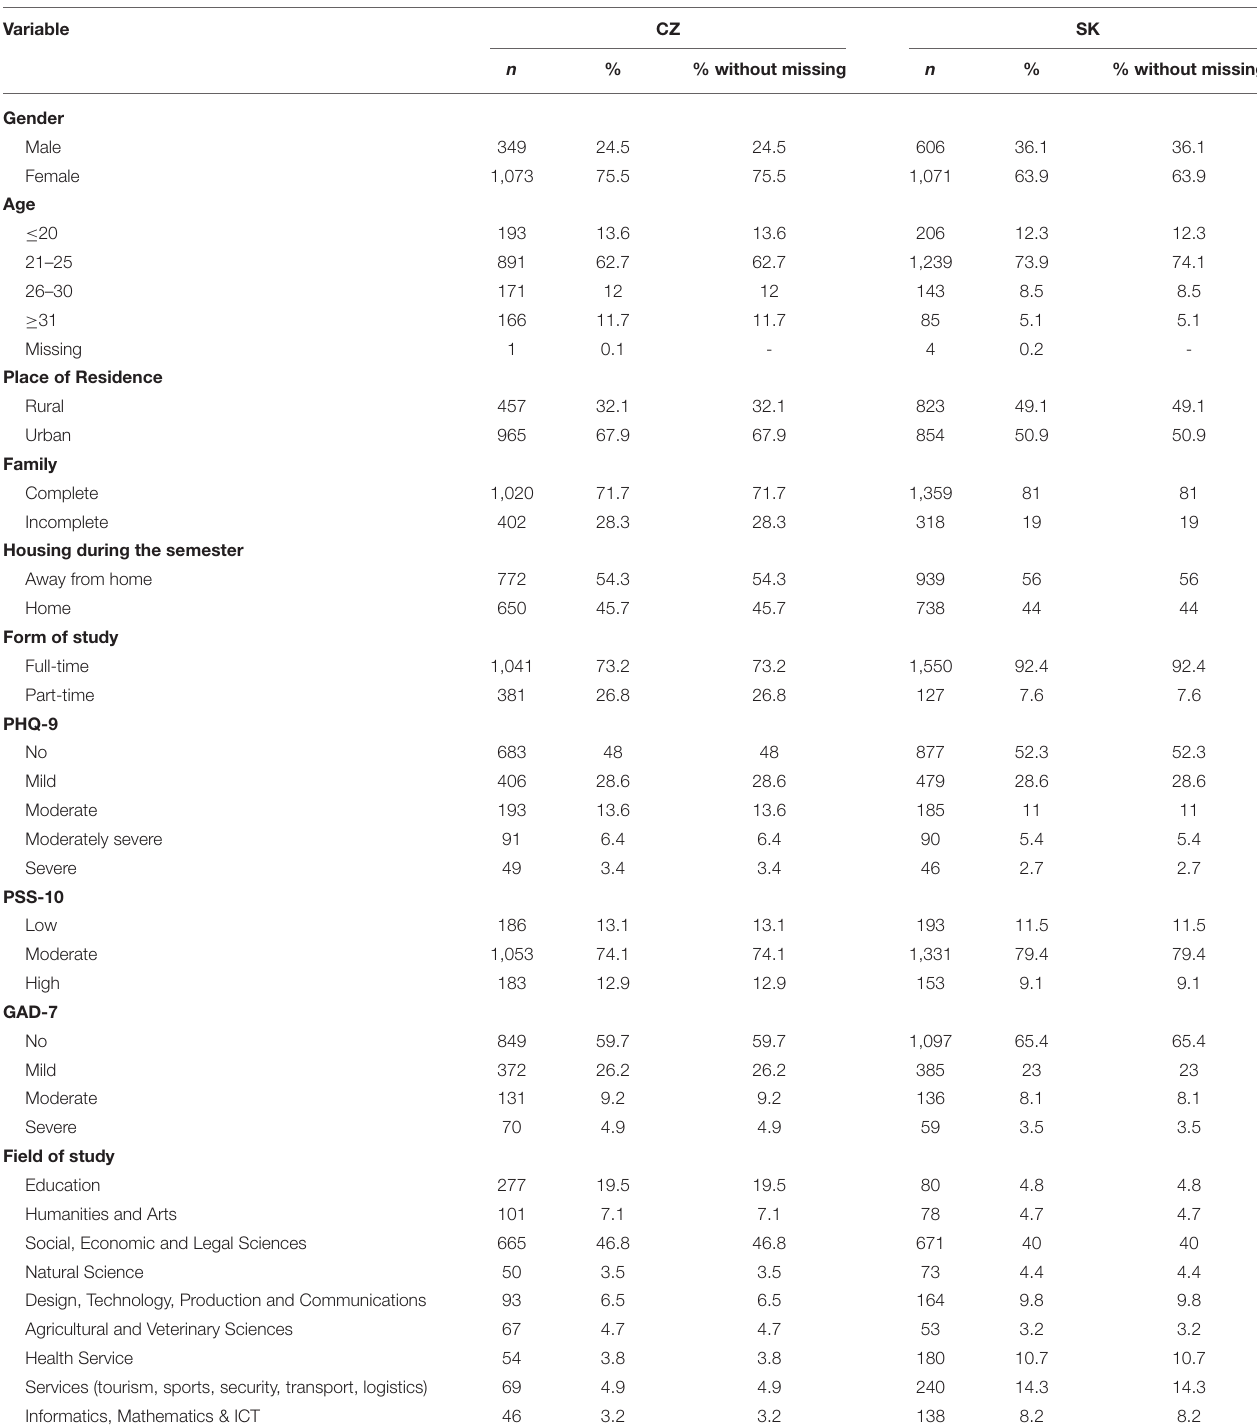
TABLE 2 | Profile of the